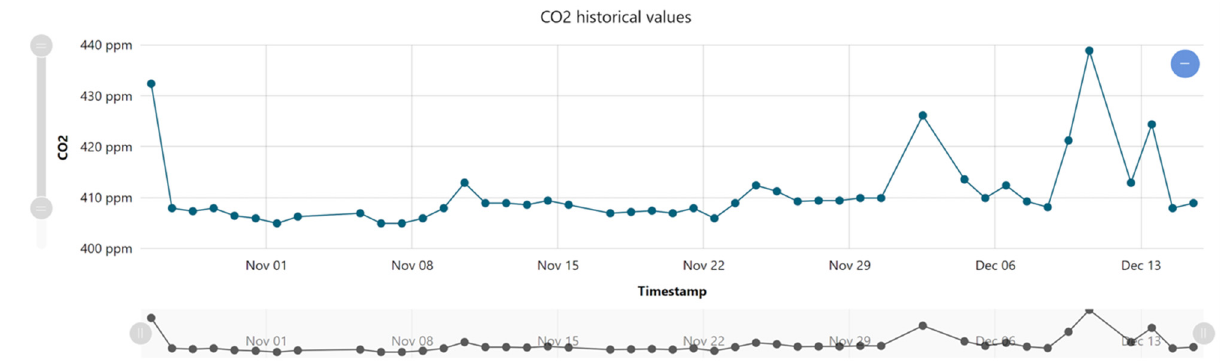
Figure 3 . Real-time evolution of CO2 levels in the area where the user is located . Figure 3. Real-time evolution of CO 2 levels in the area where the user is located.